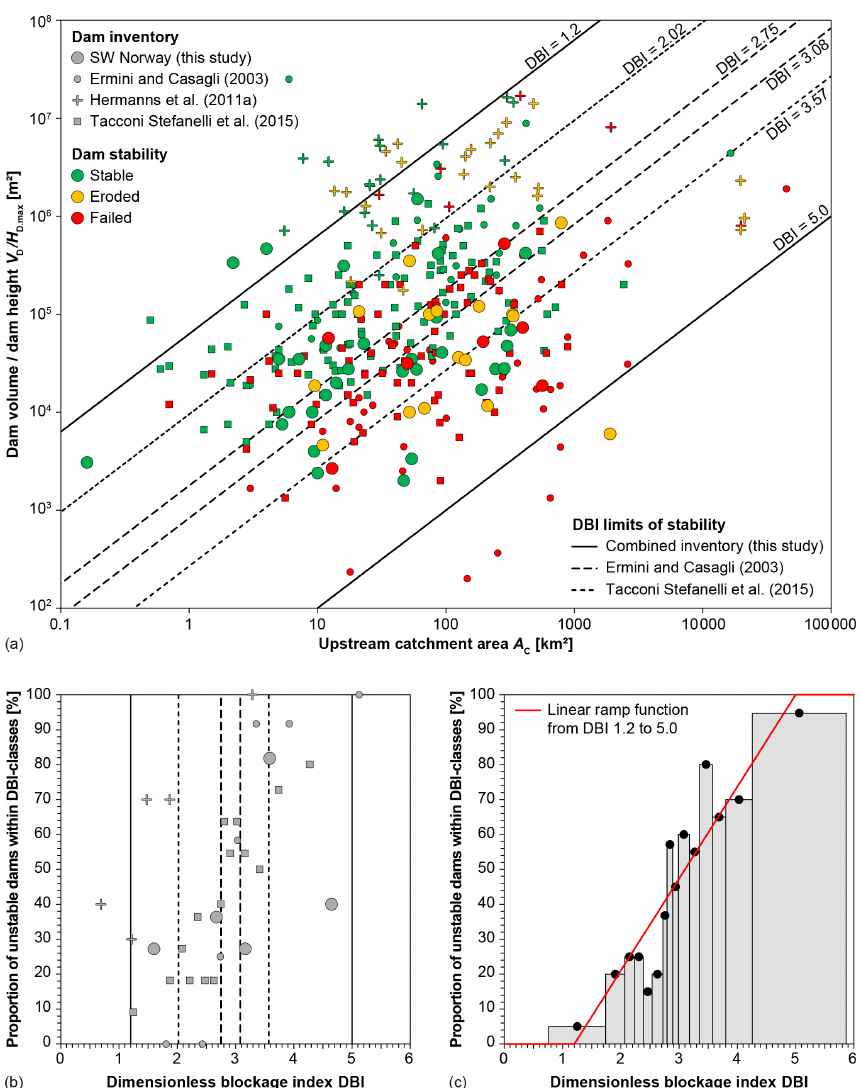
Figure 8. The dimensionless blockage index (DBI) for RSF dams in southwestern Norway: (a) the ratio dam volume V D / maximum dam height H D . max is plotted against the upstream catchment area A C for stable and unstable dams, along with the lower and upper DBI limits from Ermini and Casagli (2003), Tacconi Stefanelli et al. (2015), and this study separating the stability domain from the instability domain with a transition zone in between; (b) proportions of unstable dams for bins of DBI values (each containing 10–12 landslide dams) for different inventories along with their DBI limits (see legend in a ); (c) for the combined inventory of landslide dams (Ermini and Casagli, 2003; Tacconi Stefanelli et al., 2015, and our dataset) the proportion of unstable dams increases with DBI. A linear function is used between DBI values of 1.2 and 5.0 to assess the likelihood of a dam failure p f